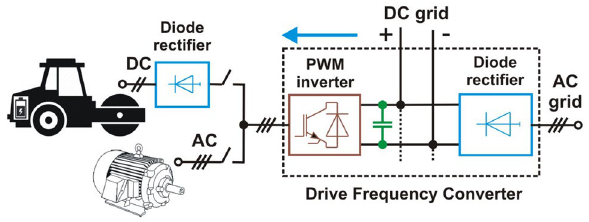
Figure 1. Proposed solution of the double function in the drive VFC 1 .